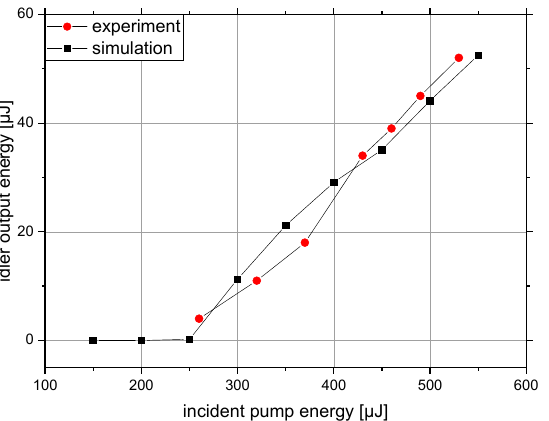
Figure 5. Measurement and simulation results of the idler output pulse energy of the NesCOPO in dependency of the incident pump power. Table 3. Parameters that were adjusted in the simulation to best fit the experimental results.